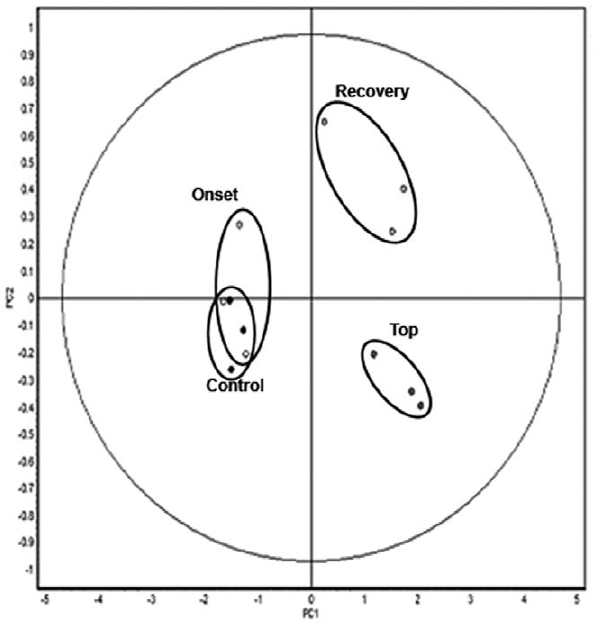
Figure 6. Unsupervised multivariate analysis discriminating between early and late groups. PCA reduces the dimensionality of a multidimensional analysis and displays the two principle components that can distinguish between the two largest sources of variation within the dataset (92 spots, ANOVA # 0.05). Principle component analysis clustering the 12 individual spotmaps into the four conditions by two principle components: PC1, which distinguishes 90% of the variance, and PC2 distinguishes an additional 3.8% of the variance.